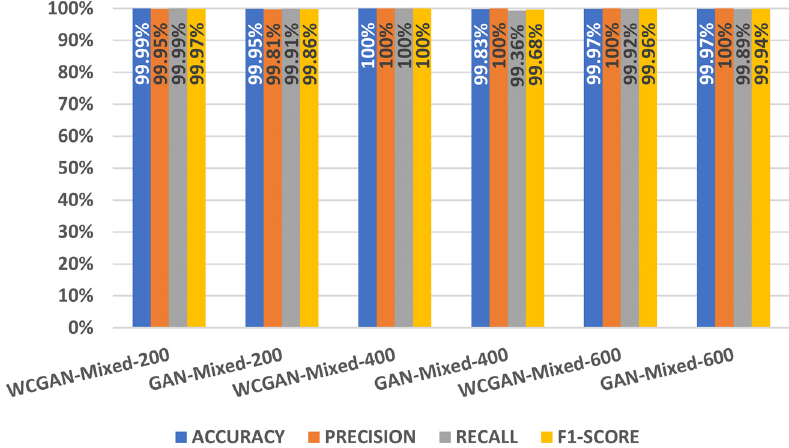
Figure 14. Histograms of the performance of our new GB-based classifiers on our mixed training sets.